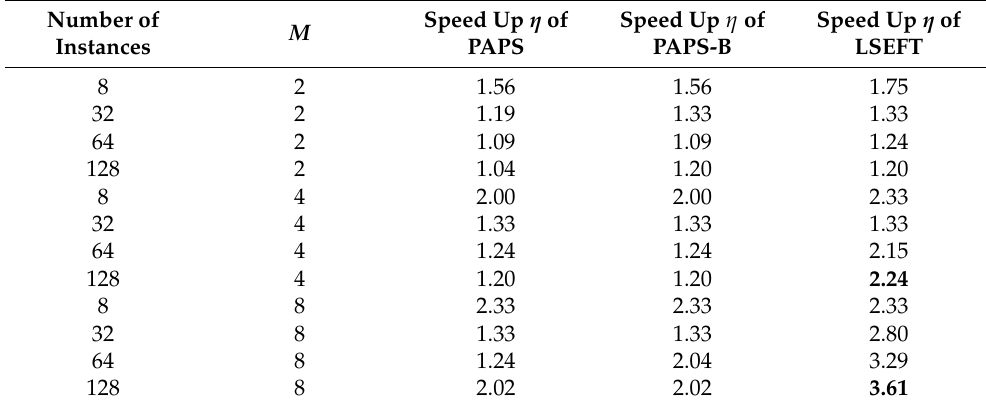
Table 3. Speed up vs. number of instances with different scheduling algorithms.